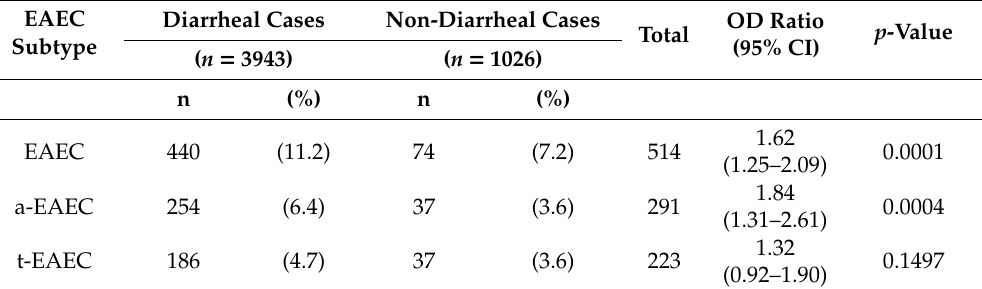
Table 1. Prevalence of enteroaggregative Escherichia coli (EAEC) and EAEC subtypes among diarrheal and non-diarrheal cases from Bolivian children less than five years of age included in the study. t-EAEC: typical EAEC, a-EAEC: atypical